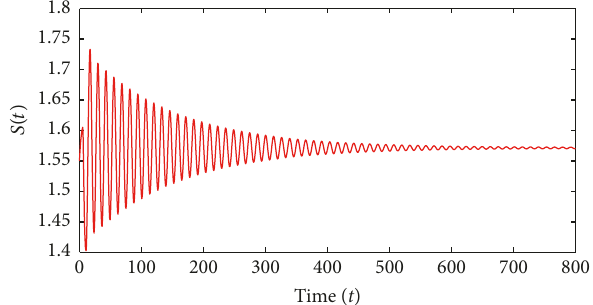
Figure 1: 𝑃 ∗ is locally asymptotically stable when 𝜏 = 5.2482 < 𝜏 0 = 5.3442 with initial functions “1.55, 0.79, 0.136, 0.75.”